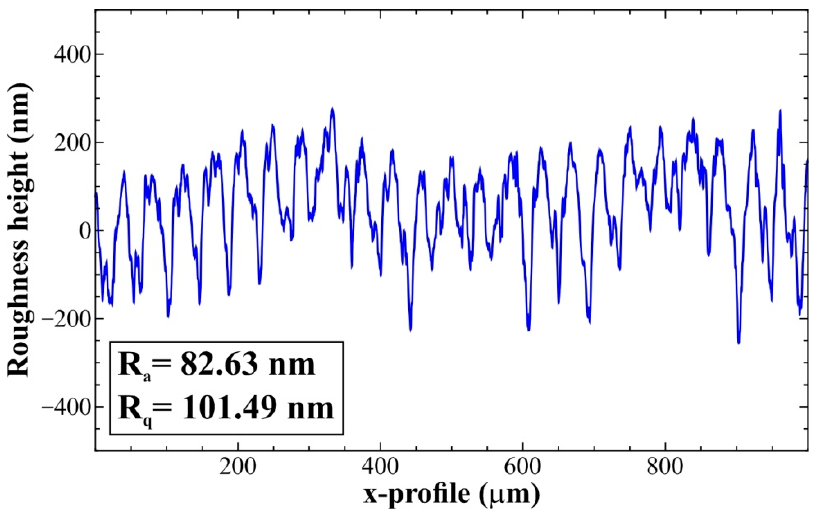
Figure 5. Results of the surface roughness studies of the final sample.